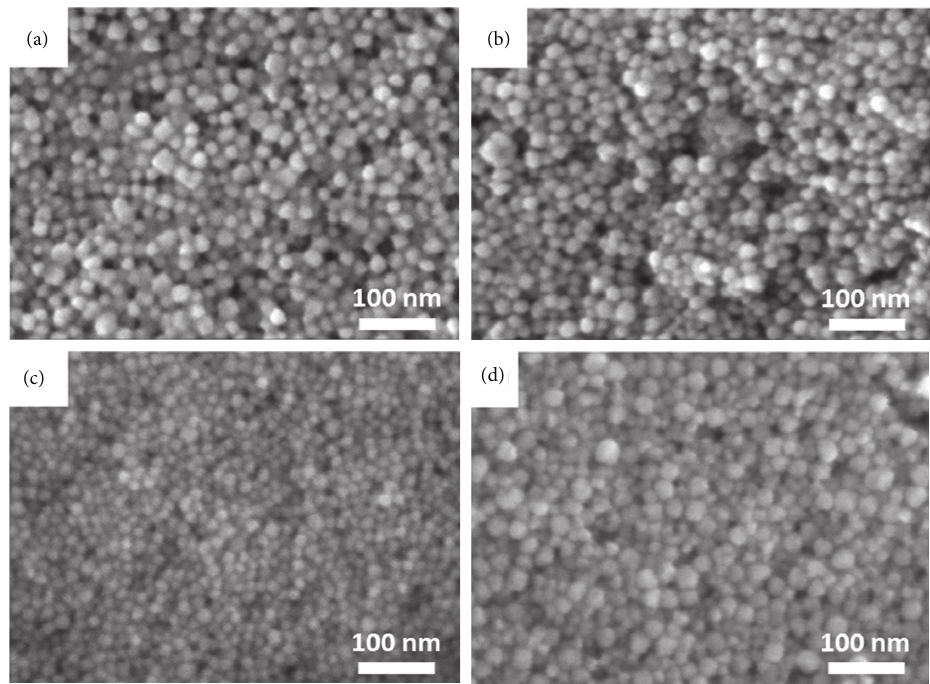
Figure 2: SEM images of PdAg-acac-1 (a), PdAg-acac-2 (b), PdAg-acac-4 (c), and PdAg-acac-5 (d). Table 1: The atomic ratio of PdAg-acac-1, PdAg-acac-2, PdAg-acac-4, and PdAg-acac-5. The atomic